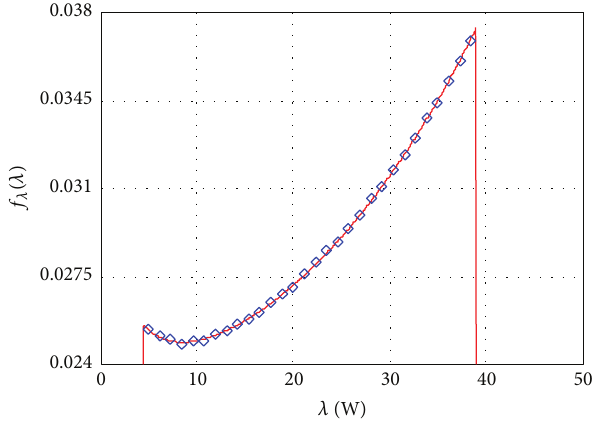
Figure 6: Amplified graph for the comparison of the pdfs obtained by the analytical method (curve) and the Monte Carlo method (scattered dots) of 10 7 simulation